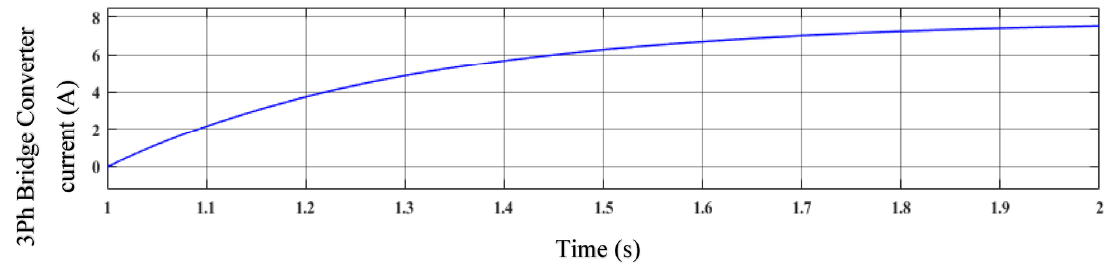
Figure 11. Three-phase bridge converter current.